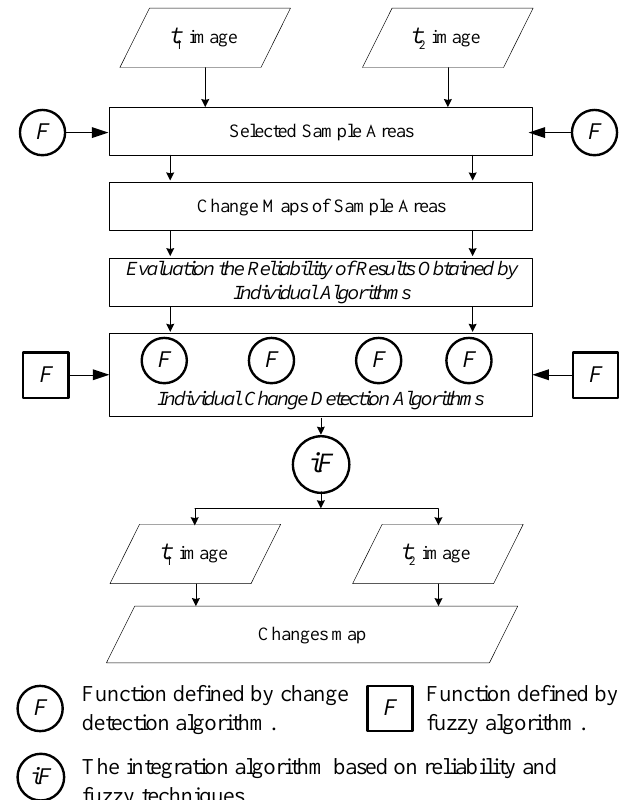
Figure 1. General scheme of the proposed